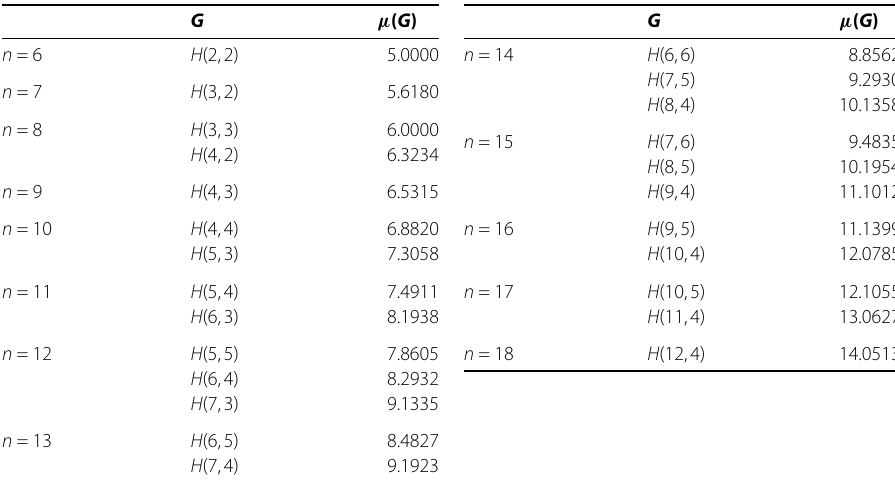
Table 2 The Laplacian spectral radii of some Halin graphs with two interior